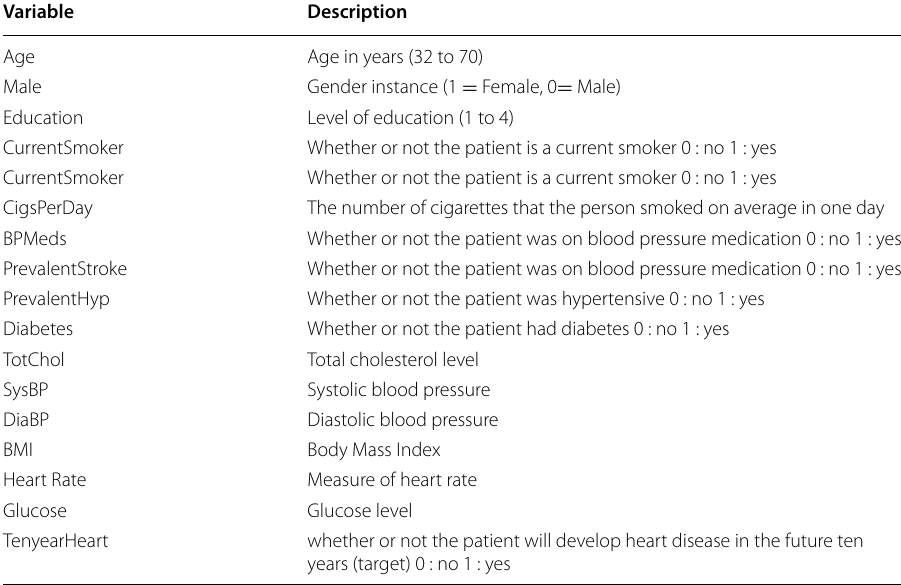
Table 2 Description of variables (Framingham